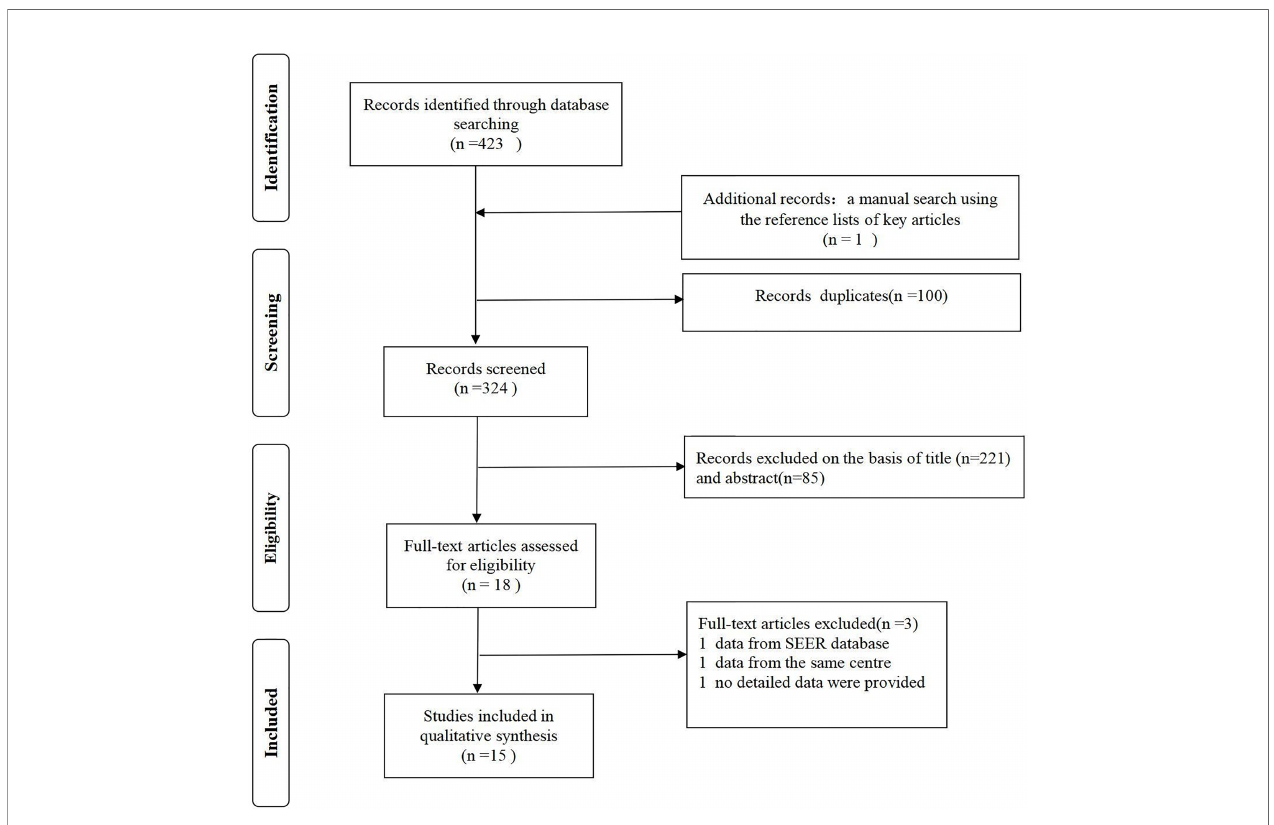
FIGURE 1 | Flow chart of study